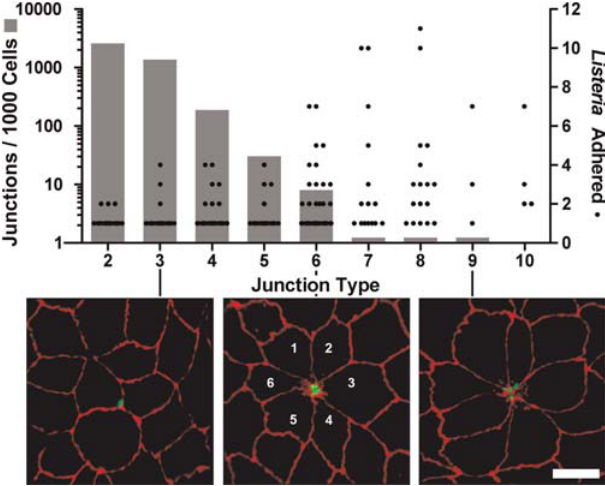
cells (Figure 3, Pearson correlation coefficient for Wt L.